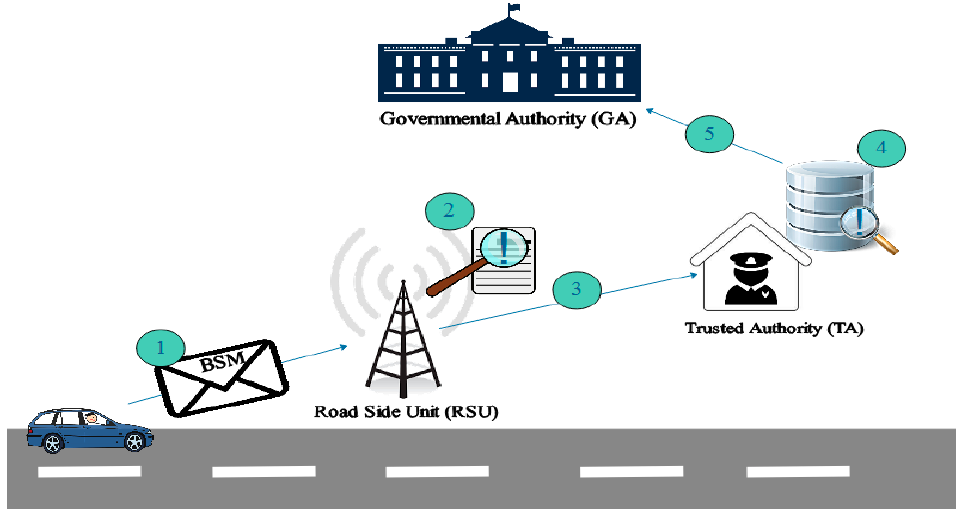
Figure 6. Scenario 2 illustration.